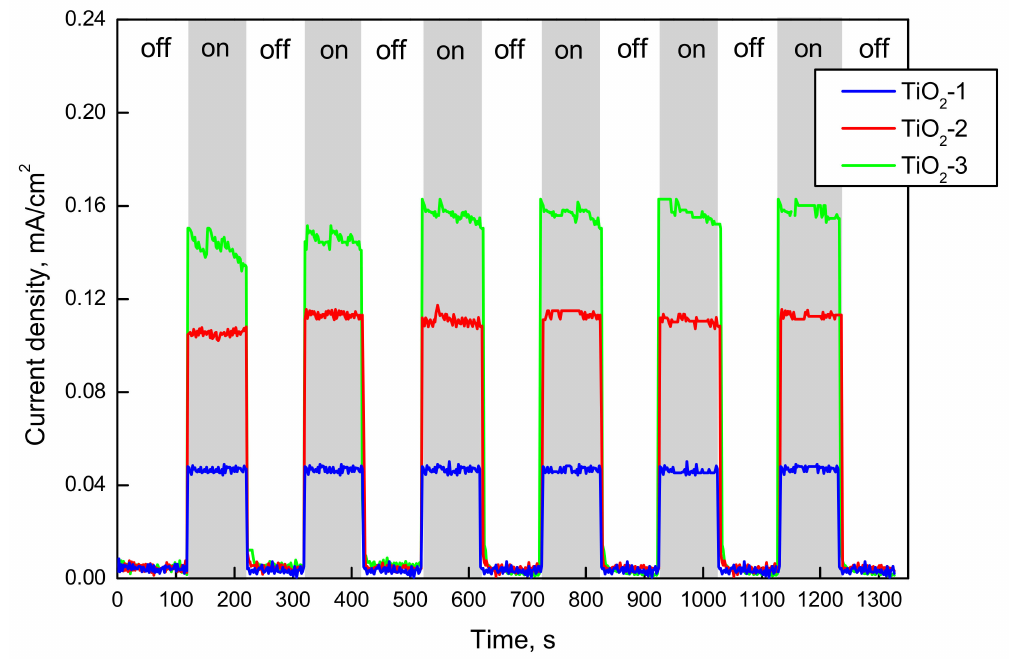
Figure 5. Photocurrent at photo-electrode (powder solids were deposited onto the graphene